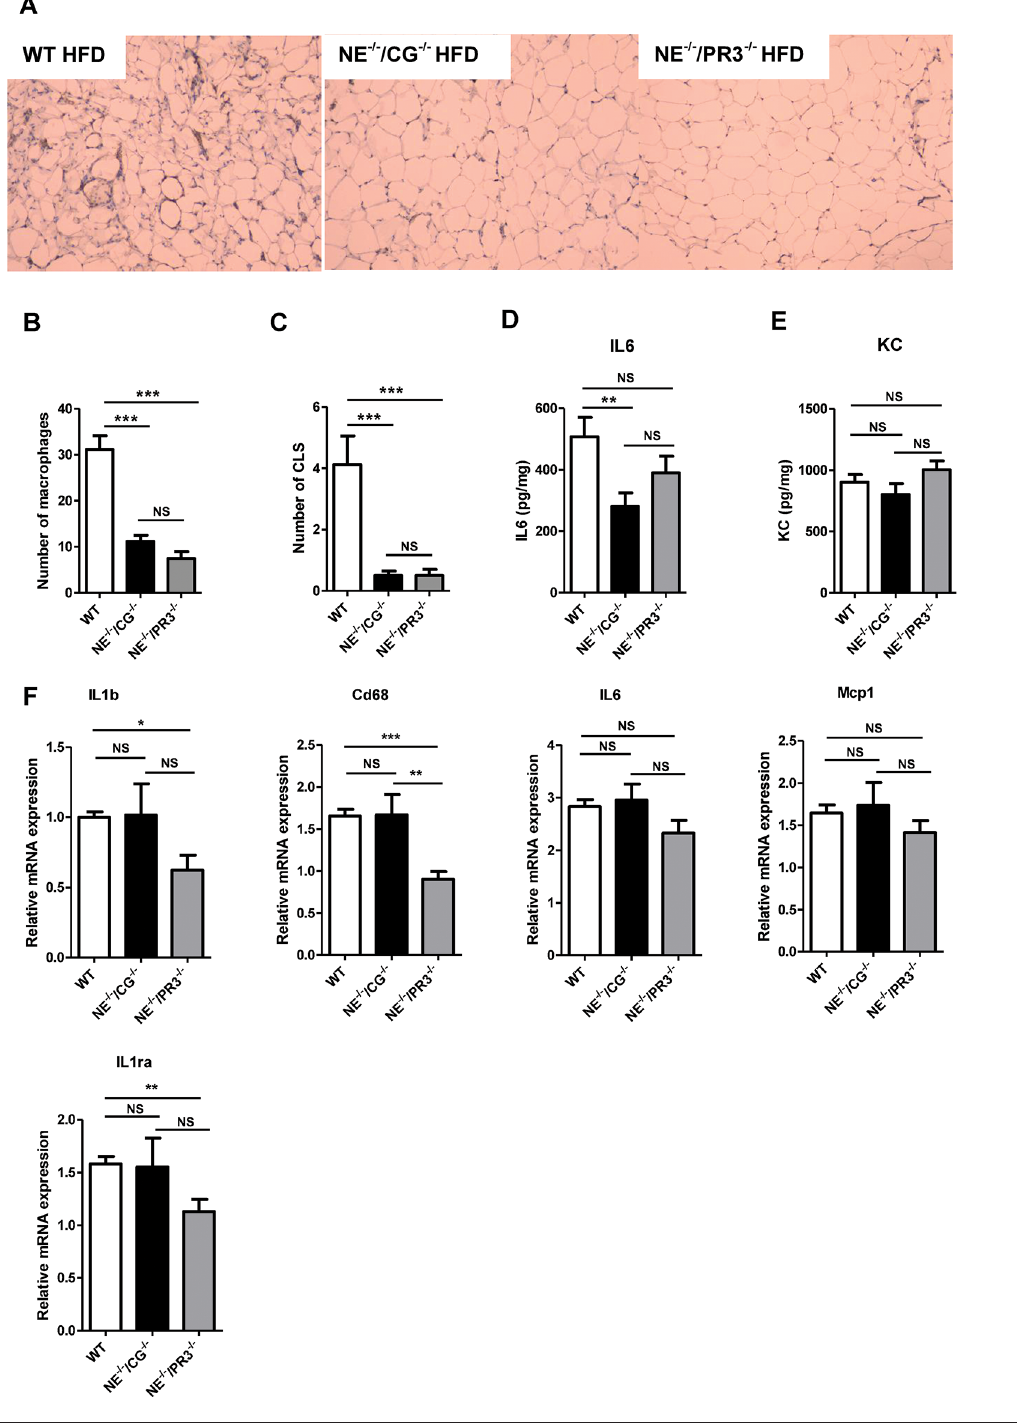
Figure 4. NE –/– /CG –/– and NE –/– /PR3 –/– mice have reduced inflammation after a high-fat diet. (A) Representative images of immunostain- ing of the macrophage marker F4/80 in white adipose tissue of wild-type, NE –/– /CG –/– and NE –/– /PR3 –/– mice. (B) Average number of mac- rophages per field. (C) Average number of CLS per field. Secretion of (D) IL-6 and (E) KC by white adipose tissue explants. (F) Relative mRNA expression of IL-1 b , Cd68 , IL - 6 , Mcp-1 and IL - 1Ra in liver. WT, wild-type; HFD, high-fat diet; CLS, crown-like structures; *significant difference p ≤ 0.05; **significant difference p ≤ 0.01 ***significant difference p ≤ 0.001; NS,